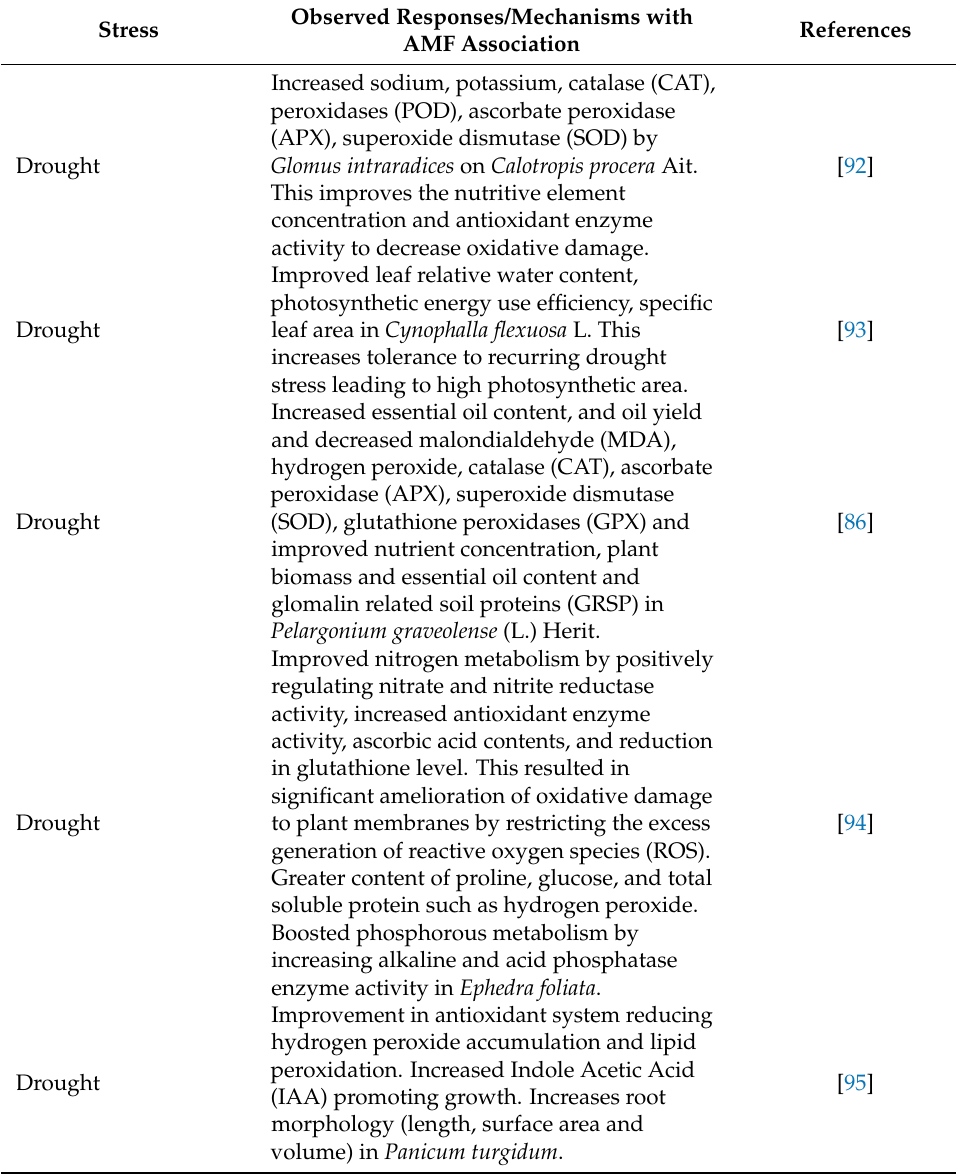
Table 1. Various abiotic stresses, observed responses and potential mechanisms involved in relation to AMF association with the host plant